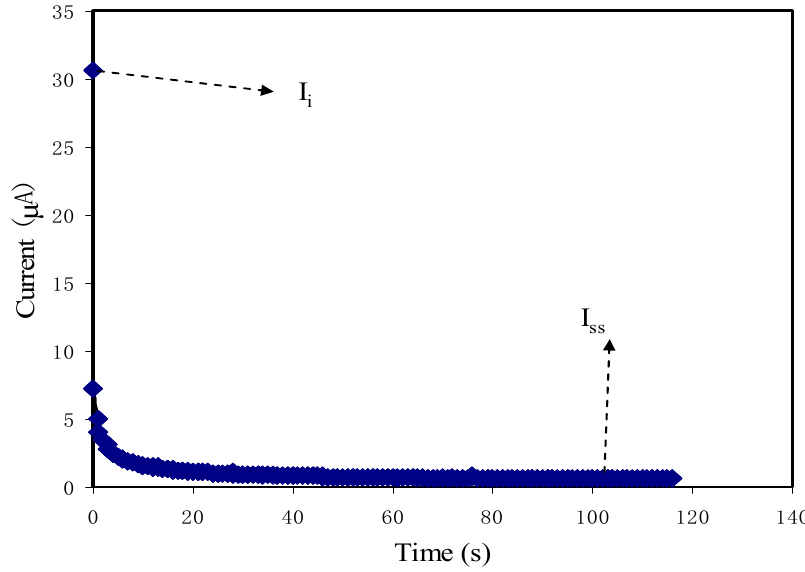
Figure 9. Current versus time for the CSNZG3 electrolyte sample.